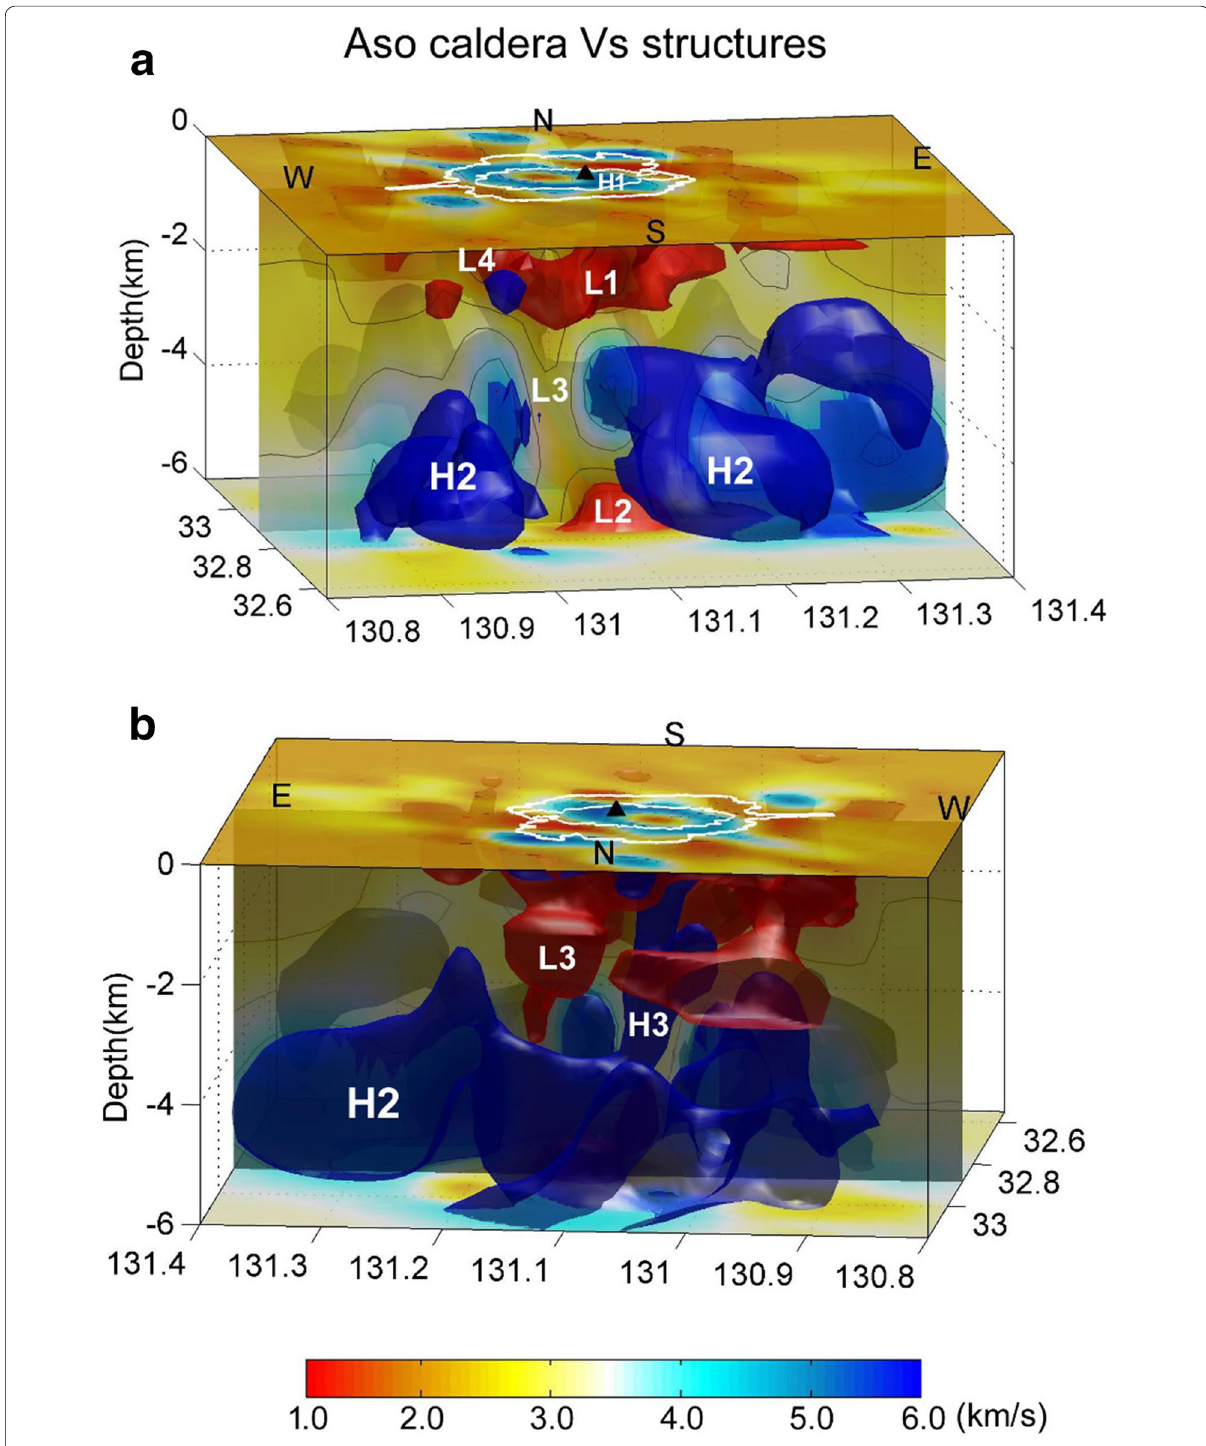
Fig. 15 Two 3‑D V s structures located 6 km beneath Aso caldera. Cross sections provide perspectives from the a south and b north. The black triangle marks the location of the Nakadake crater. Red shapes indicate V s the same velocity anomalies as displayed in Fig.